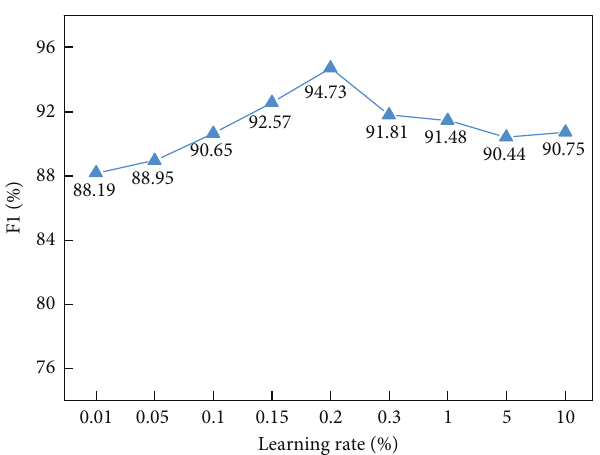
Figure 11: Relationship between NumHiddenUnits and F1. Table 3: Optimal hyperparameter